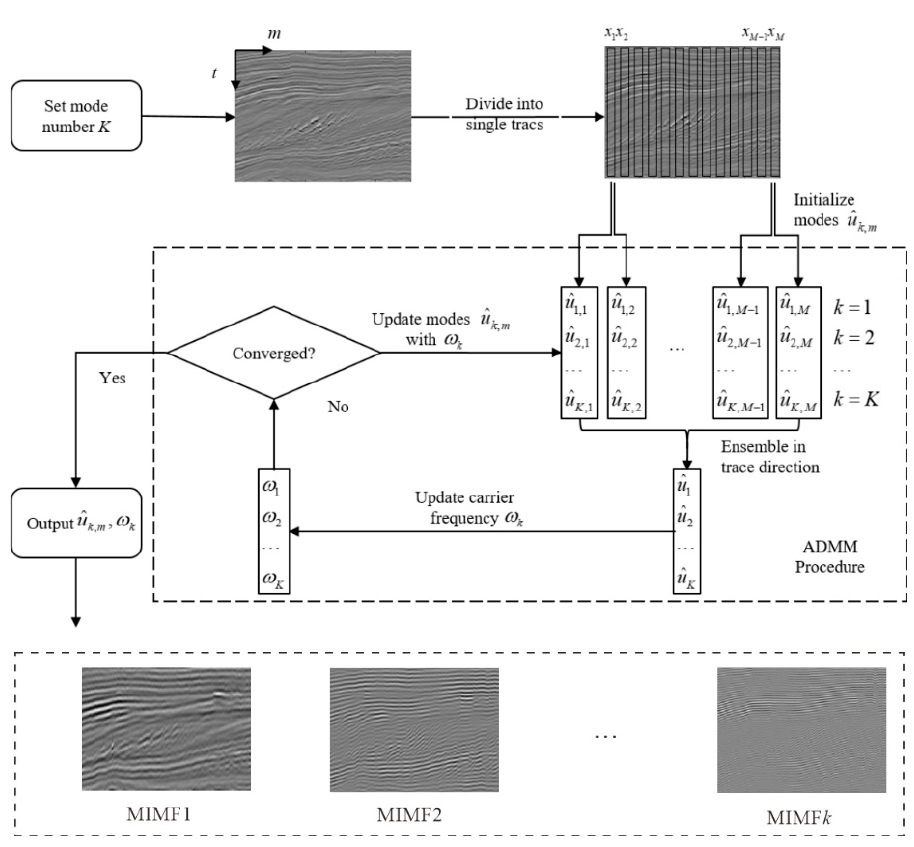
Figure 1. A flowchart of the MVMD algorithm for 2D seismic data.